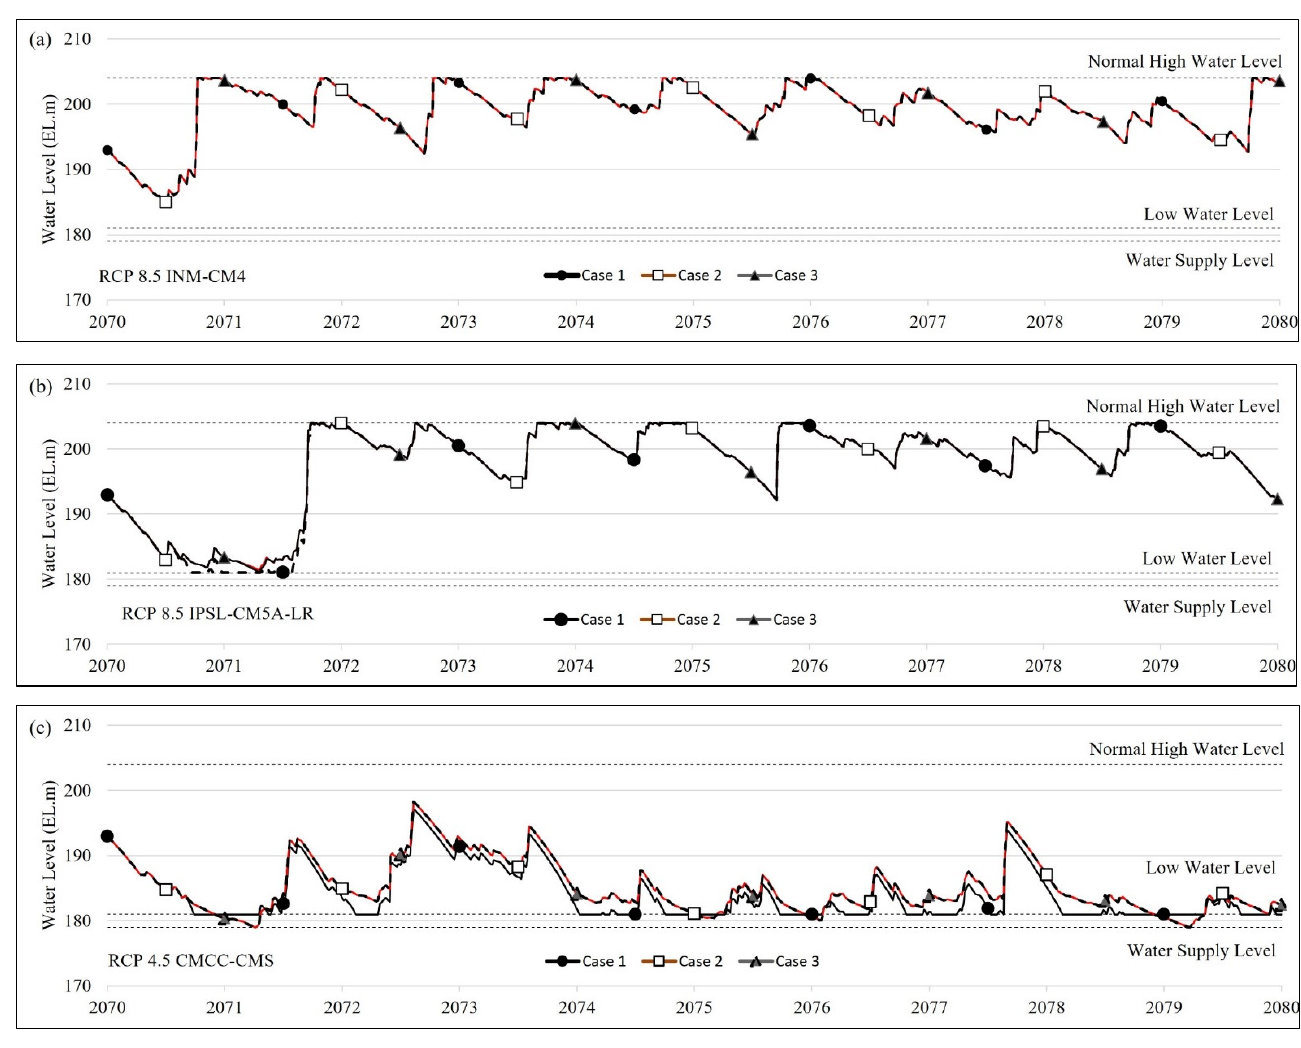
Figure 8. Changing water level in Gunwi reservoir for Case 1, Case 2, and Case 3 in Scenario RCP 8.5 INM-CM4 ( a ), RCP 8.5 IPSL-CM5A-LR ( b ), and RCP 4.5 CMCC-CMS ( c ) from 2070 to 2080.